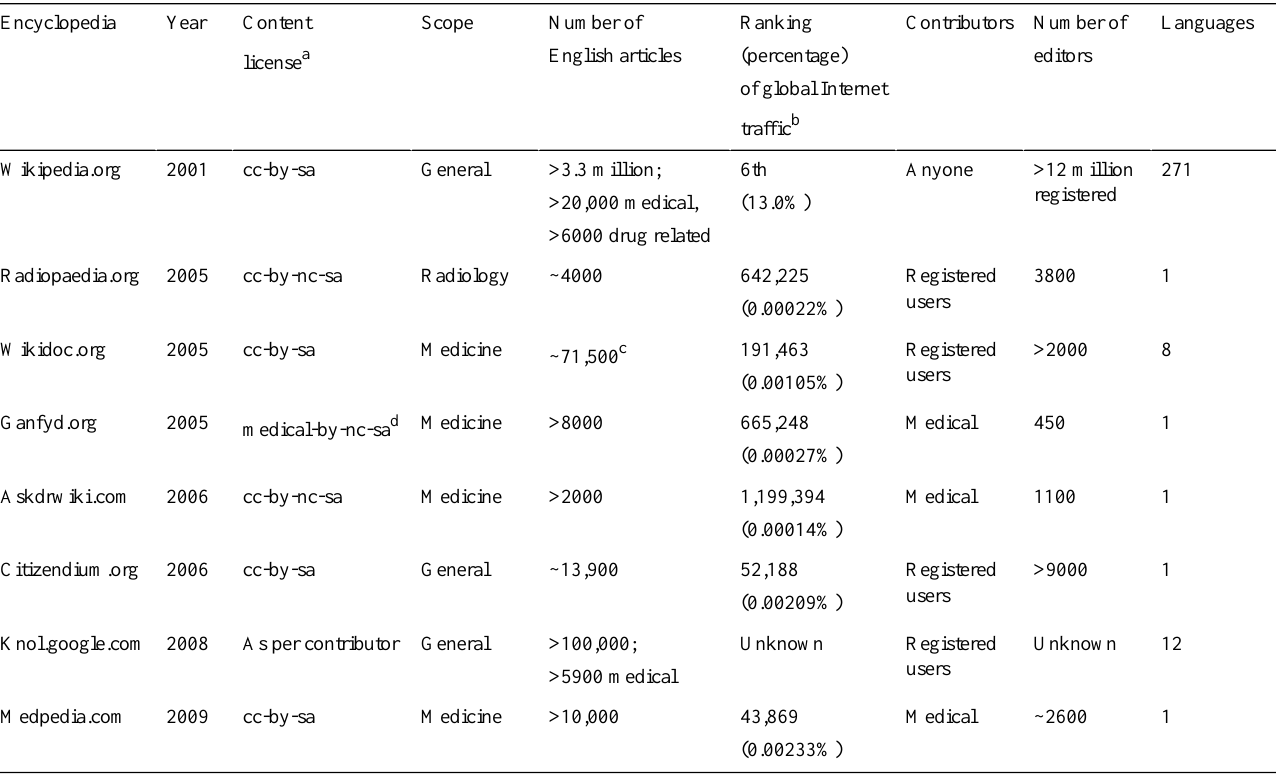
Table 1. Comparison of selected wikis containing medical